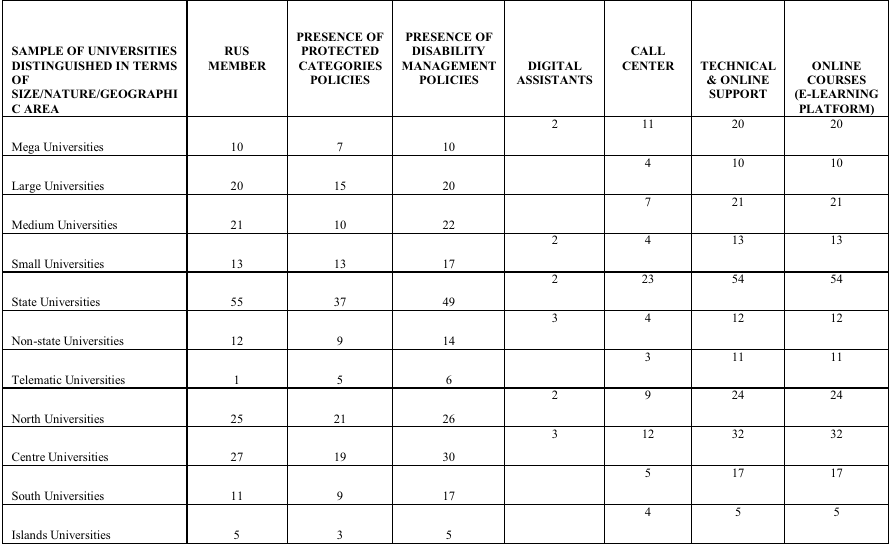
Table 1: A brief portrait of the Italian